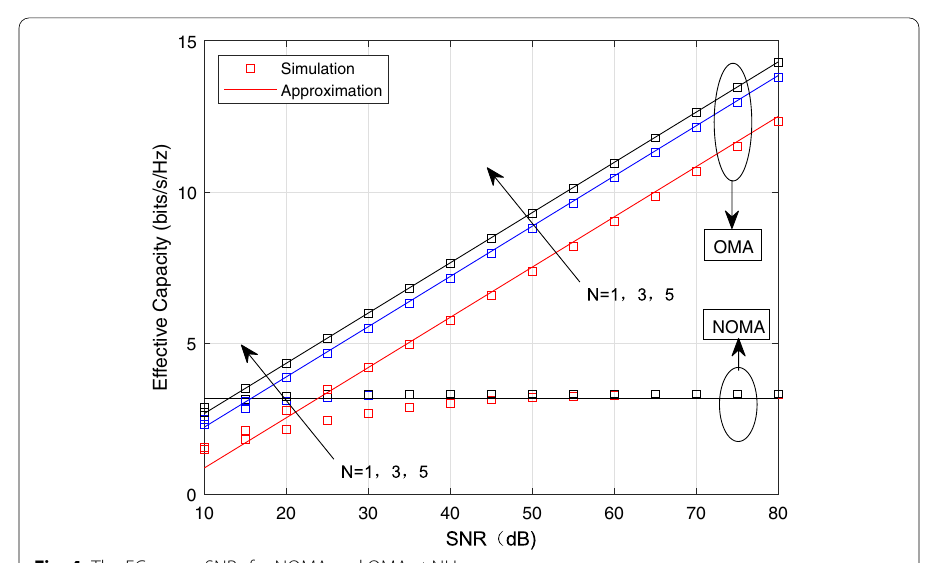
Fig. 4 The EC versus SNRs for NOMA and OMA at